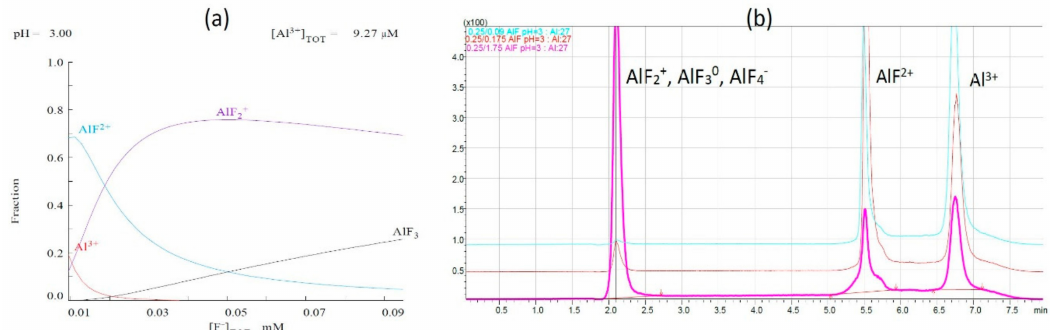
Figure 2. ( a ) Data from chemical modeling program for 1:1 and 1:10 Al / F molar ratio and ( b ) overlapped chromatograms Al / F for 1:0.5, 1:1, and 1:10 molar